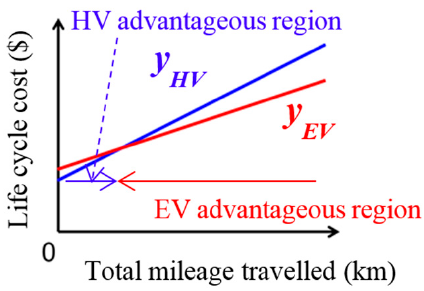
Figure 3. LCC comparison between HV and EV.